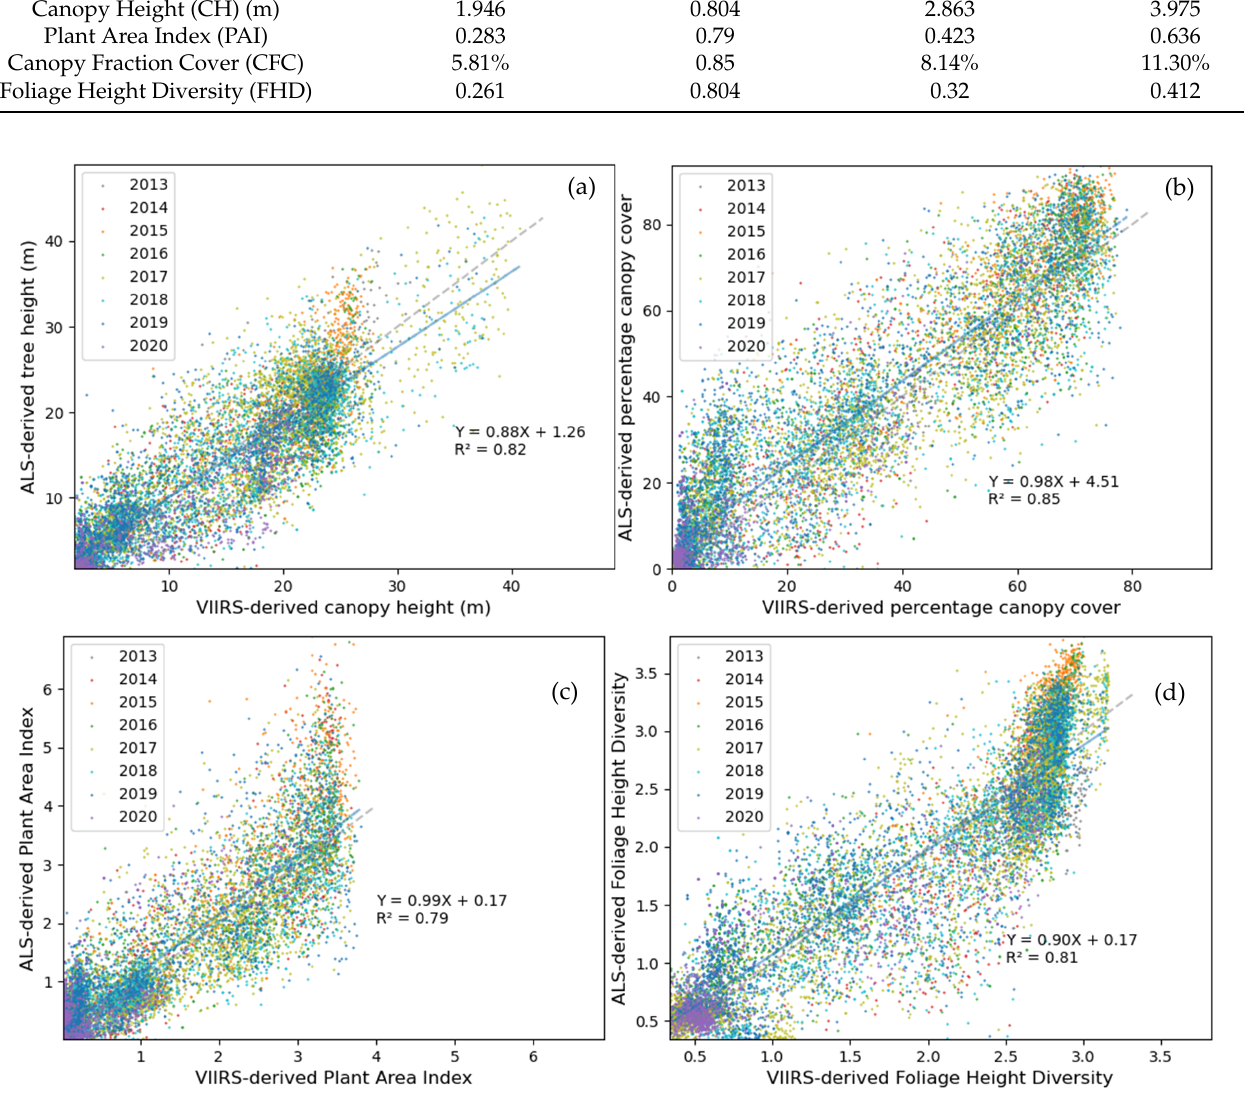
Figure 10. Scatter plots between VIIRS-derived and ALS-derived: ( a ) canopy height; ( b ) canopy fraction cover; ( c ) plant area index; and ( d ) foliage height diversity. Different years are represented in different colors. Table 12. Evaluation results of the annual mapped products’ comparison with the ALS data for the period 2013–2020.